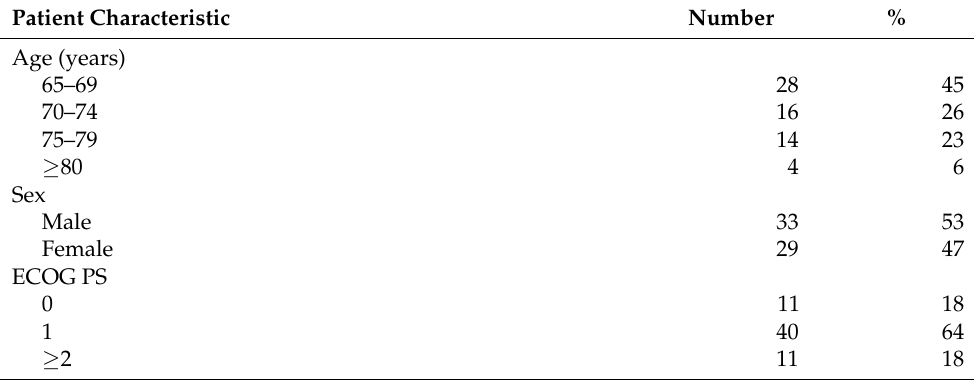
Table 2. Patient